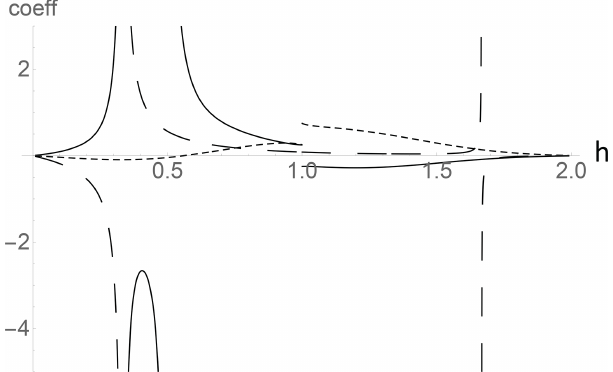
Figure A2. The solid line is the constant term F 1 , the long dashes (cid:48)( 1 − 3 h) of the fractional power, and the are the coefficients D 3 2 short dashes are the coefficients of the linear term: F 2 = C 2 + D 2 + D 3 . We can see that the contribution of the linear term 2 h − 2 2 ( 3 h − 2 ) (used in the R 0 ,h, 2 , 2 (t) approximation) for h < 1 and t < 1 is fairly small, whereas for 1 < h < 2, it is larger and the R 0 ,h, 2 , 2 (t) approx- imation is significantly better than the R 0 ,h, 2 , 1 (t) approximation (see Fig. A3).